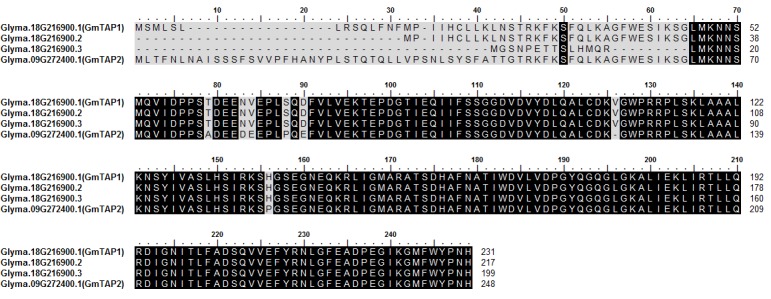
Alignment of amino acid sequences of three isoforms of GmTAP1 and paralog GmTAP2 by ClustalW.Dashes indicate gaps introduced to optimize the alignment.